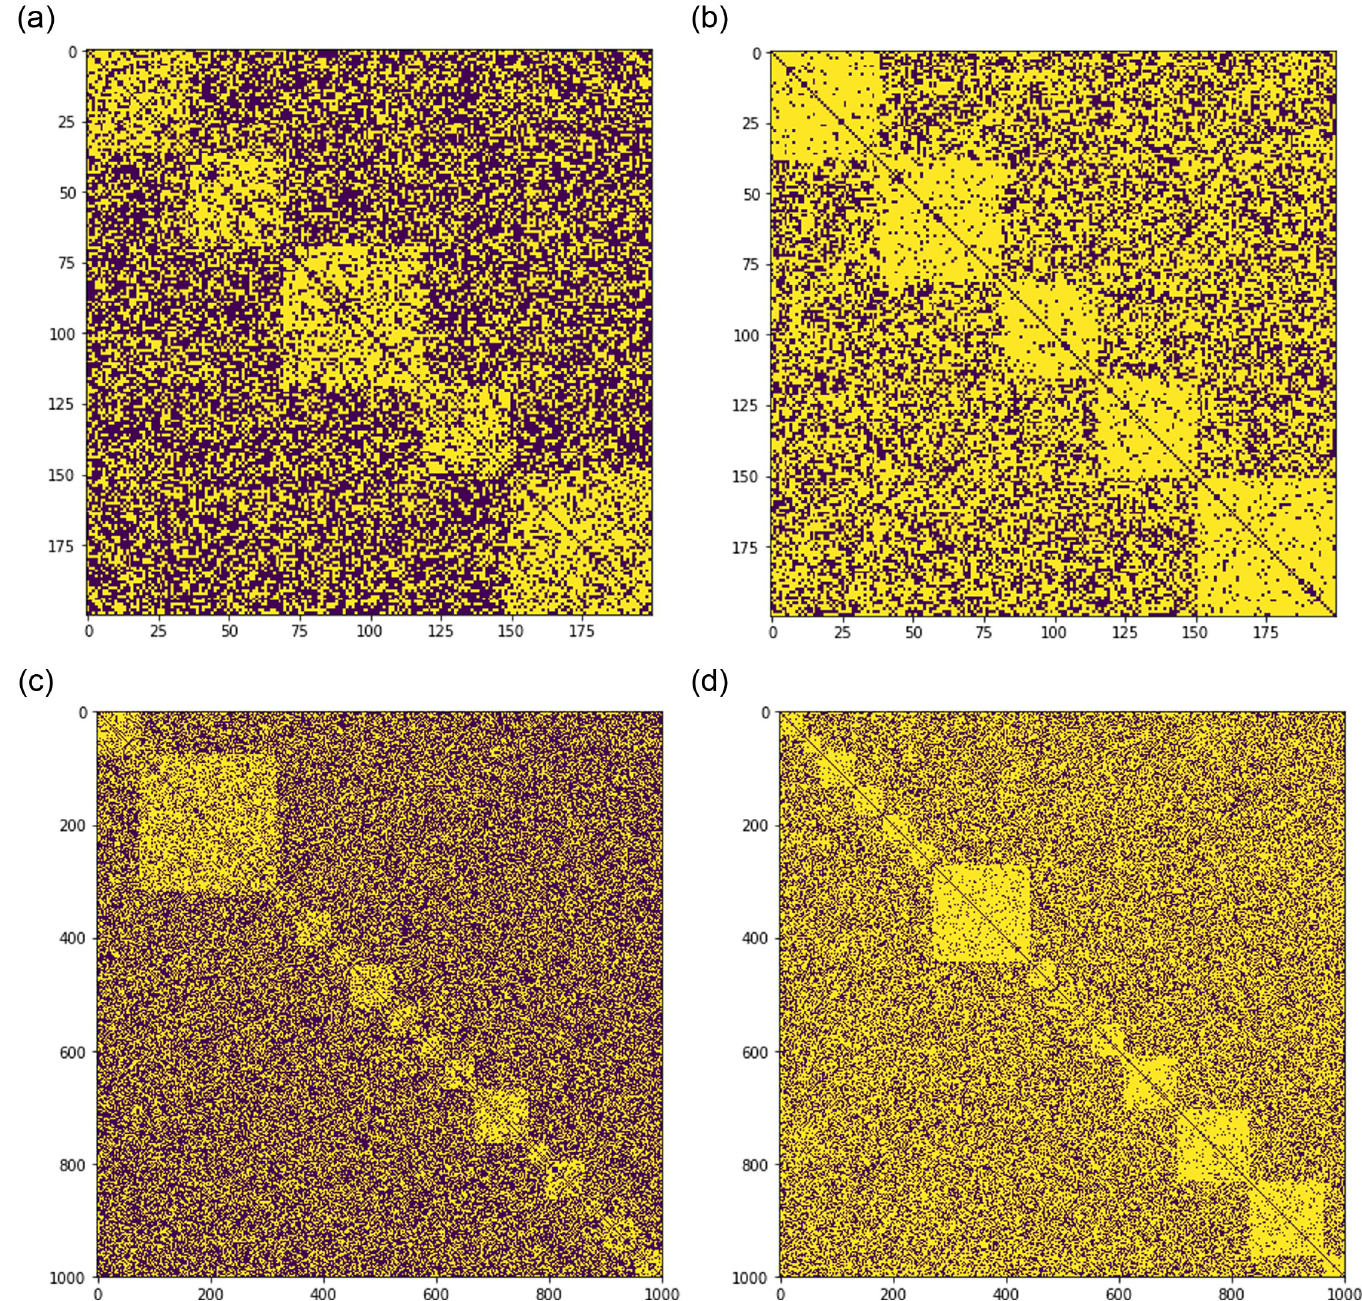
Fig 1. Samples of synthetically generated network matrices (white pixels represent unities, and dark ones, zeros). The number of nodes is N and the number of communities is K . Values p , q are the probabilities of drawing edges within-community and between communities, respectively. Specifically, p = 0.7, q = 0.4, N = 200, K = 5 at (a), p = 0.9, q = 0.6, N = 200, K = 5 at (b), p = 0.7, q = 0.4, N = 1000, K = 15 at (c), and p = 0.9, q = 0.6, N = 1000, K = 15 at